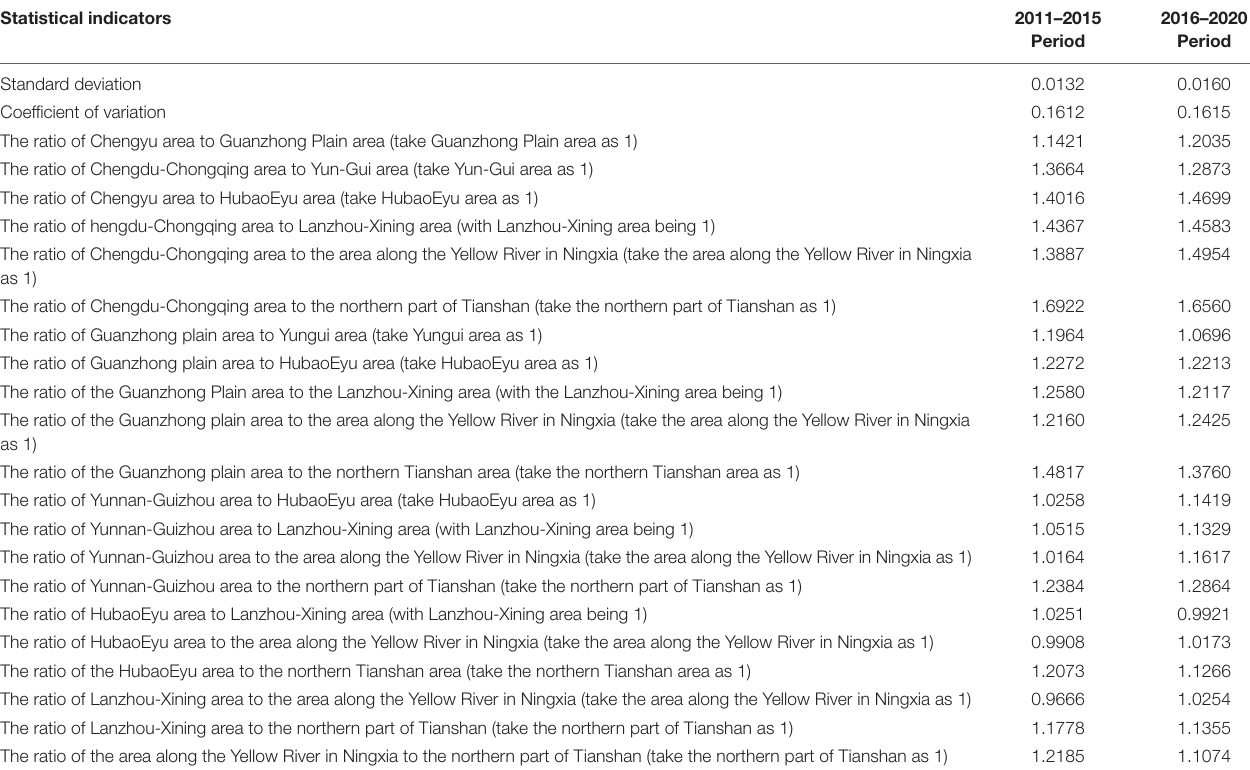
TABLE 10 | Relevant indicators of the social development gap between urban agglomerations in western China. Statistical